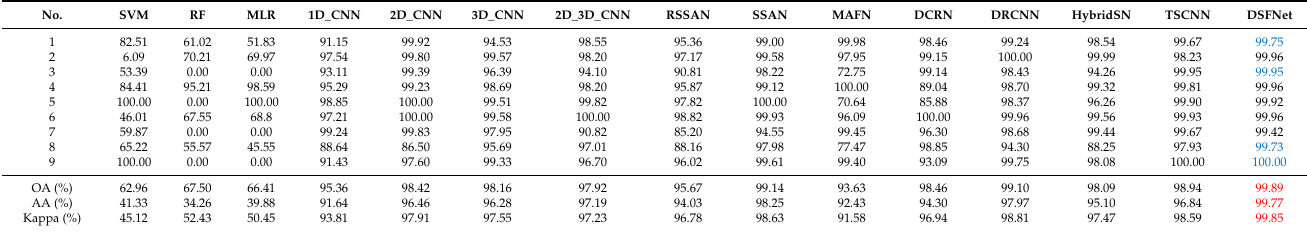
Table 6. Classification results on the UP dataset.